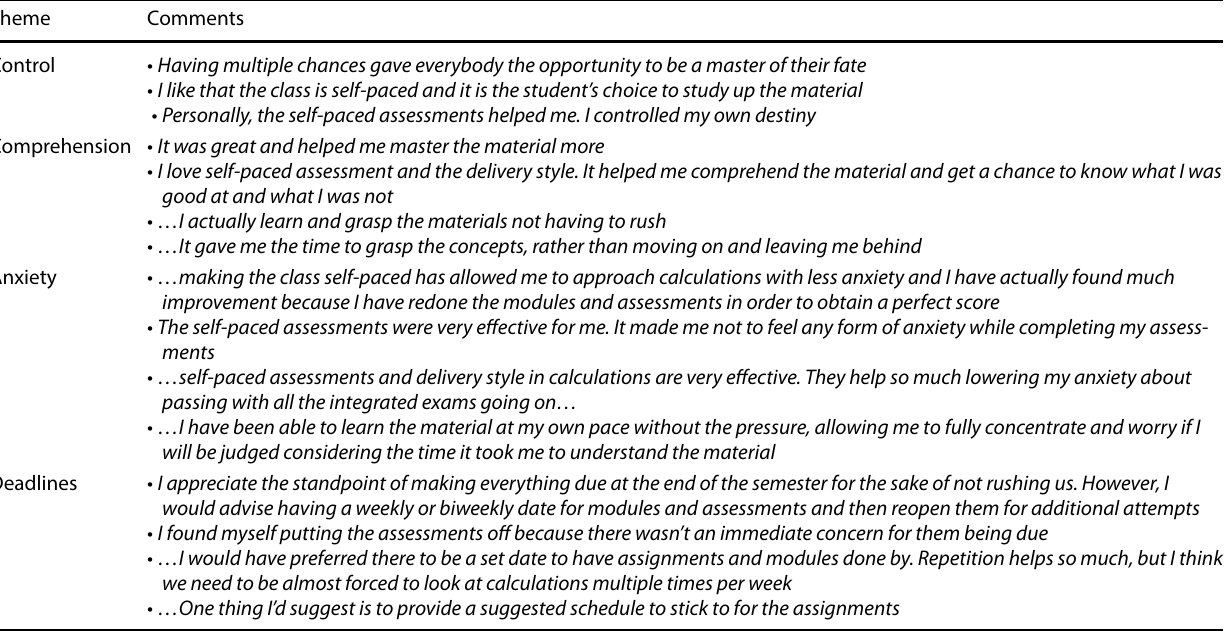
Table 4 Student comments about self-pacing and multiple-attempt